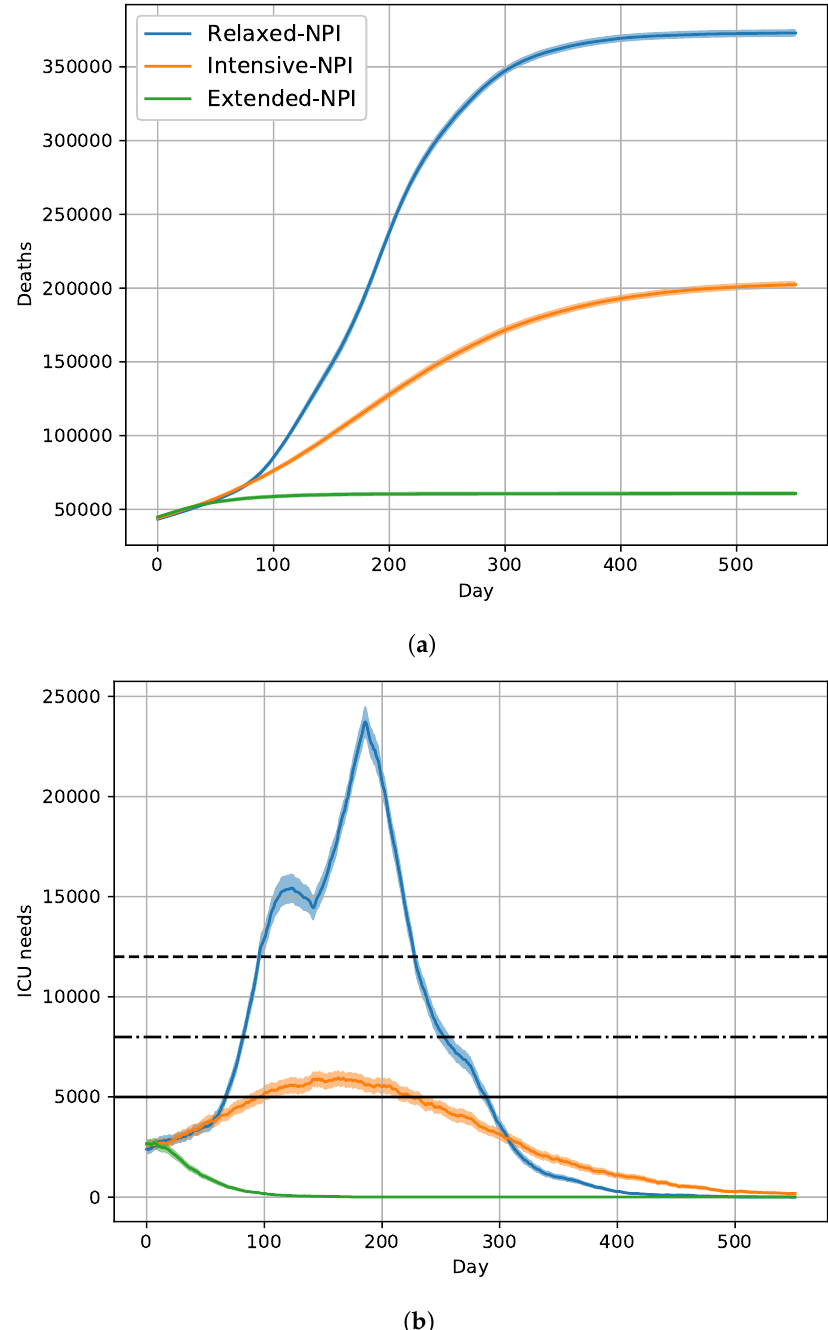
Figure 1. Expected evolution of the COVID-19 epidemic in France for the historical strain, with- out vaccination, for extended-NPIs, intensive-NPIs, and relaxed-NPIs, as well as for 20% rate of asymptomatic subjects. Day 0 is 1 January 2021; ( a ) cumulative number of deaths. ( b ) Prevalence of COVID-19 patients needing intense care units. The horizontal black lines represent ICU capacities of 5000, 8000, and 12,000